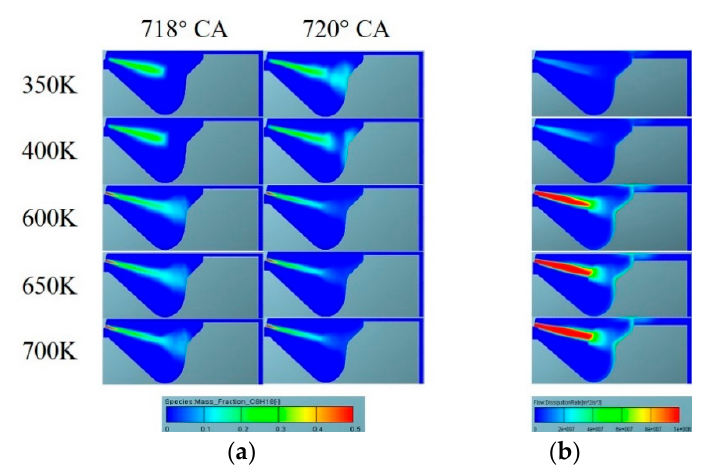
Figure 5. (a) Comparison of fuel quality score distribution in the cylinder at combustion time. (b) Comparison of the diffusion rate in the cylinder at 730° CA.